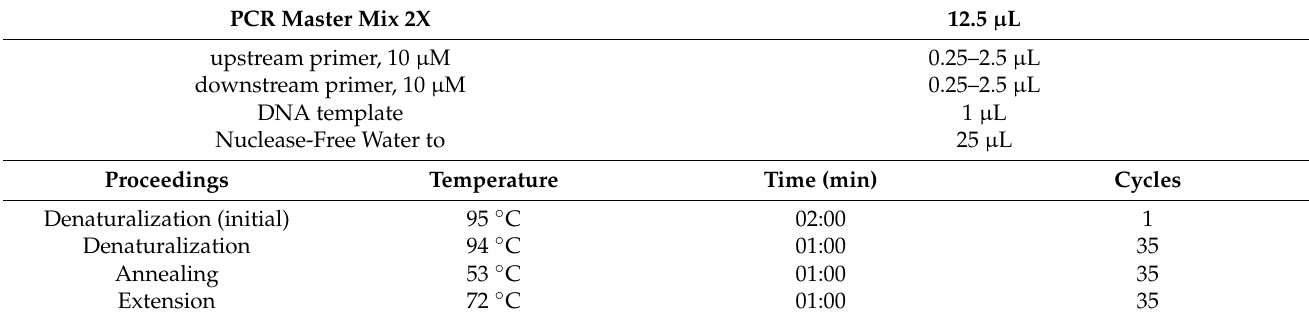
Table 3. Amplification